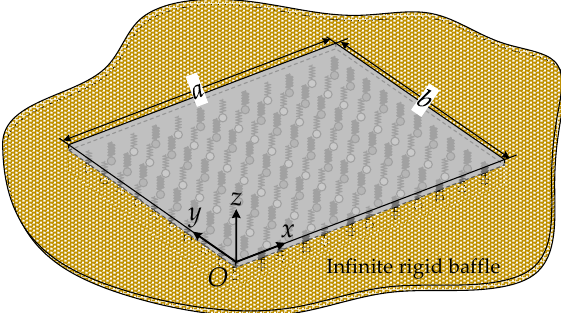
Figure 2. Schematic of the locally resonant plate embedded in an infinite rigid baffle.